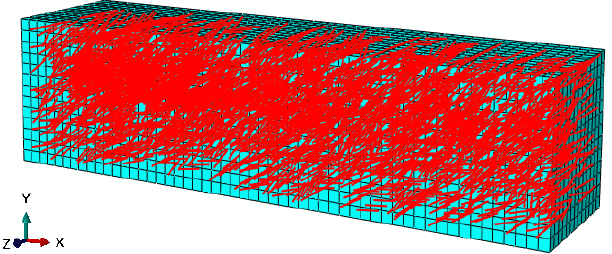
Figure 9. Finite element (FE) model for the FRAM sample.